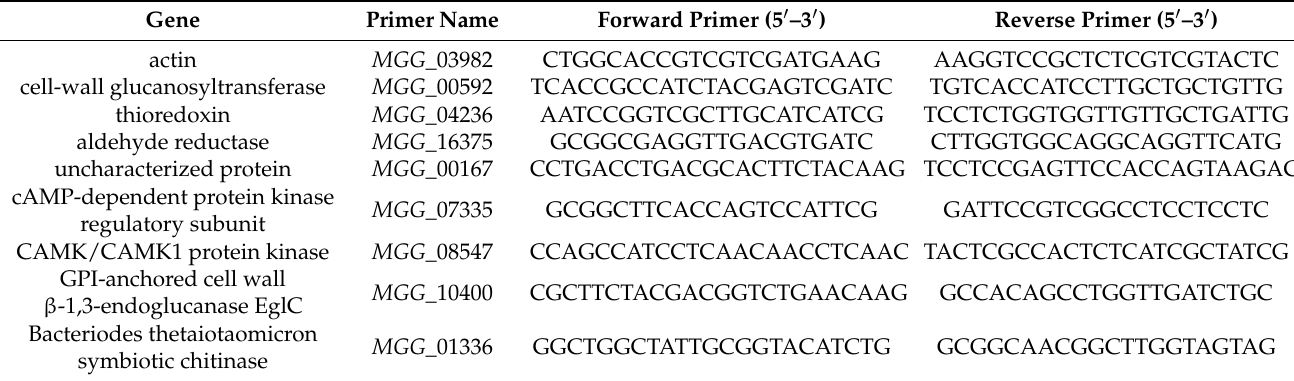
Table 1. Primer design for